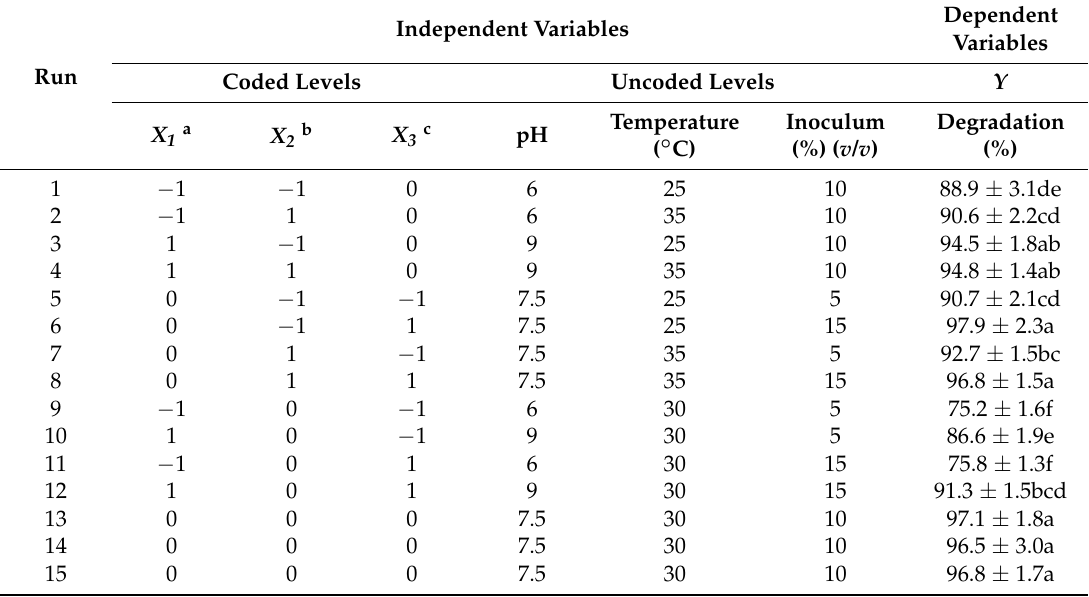
Table 1. Box-Behnken experimental design matrix and the response of dependent variables for beta-cypermethrin degradation by B. cereus